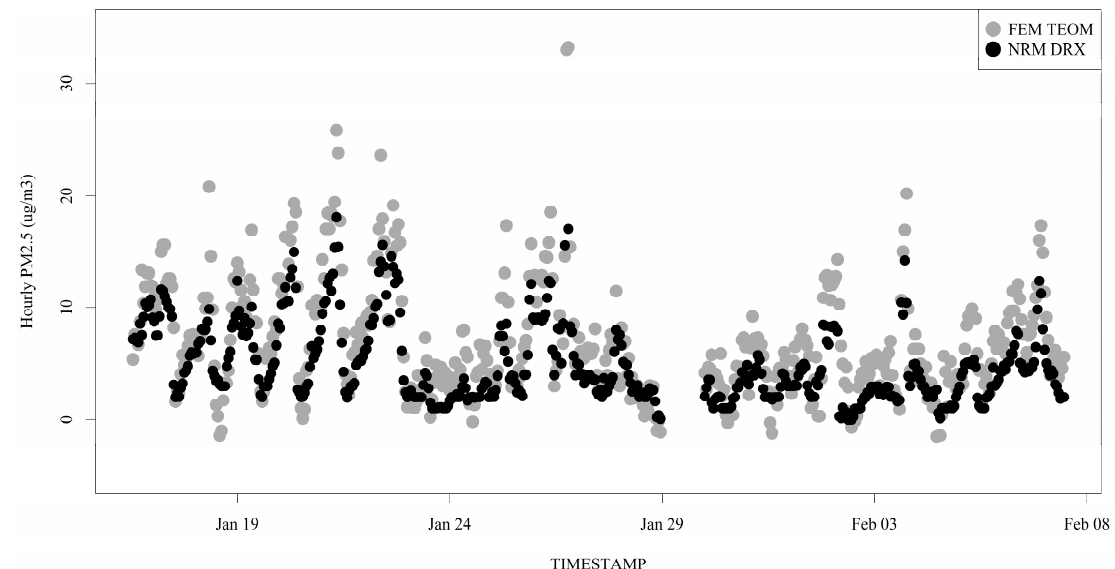
Figure 3. Timeseries of raw hourly NRM PM 2.5 and FEM measurements.